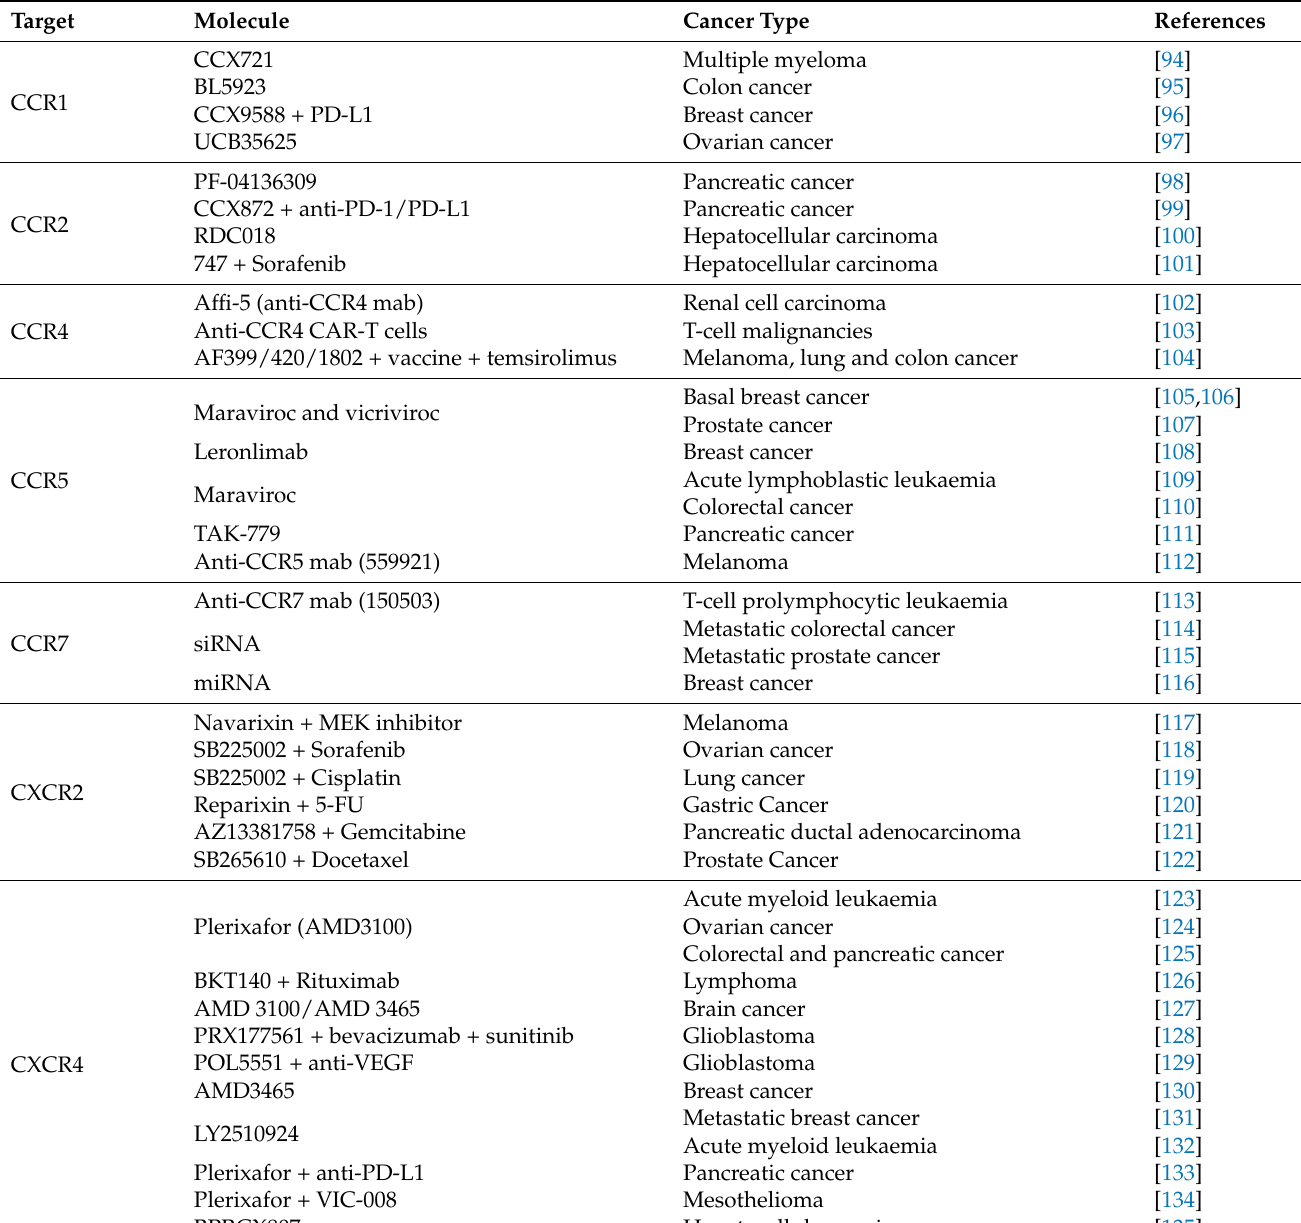
Table 2. Pre-clinical studies of chemokine inhibition in